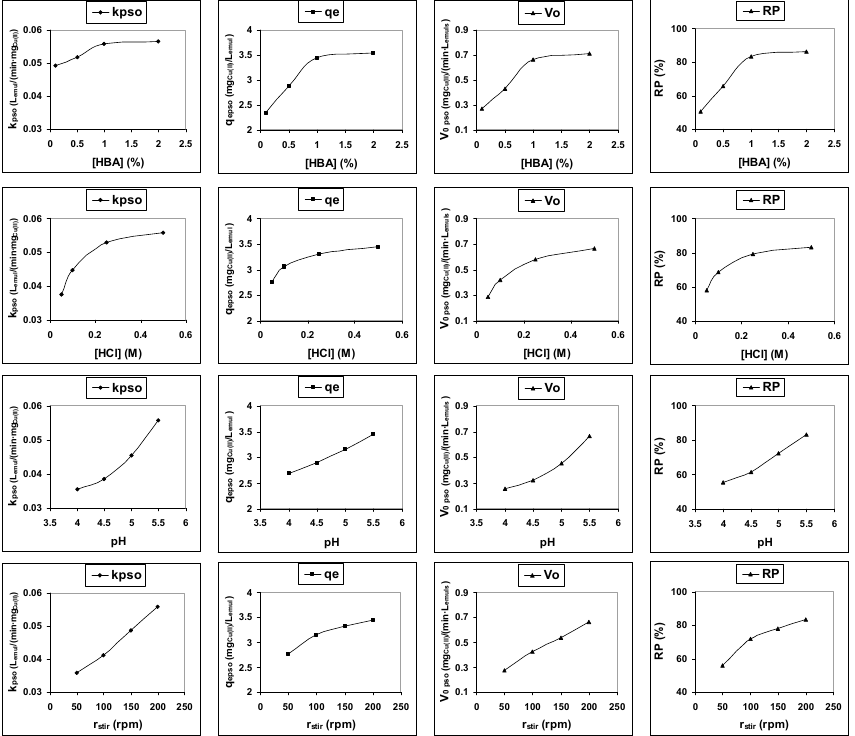
Figure 5. Variation in the values of pseudo-second-order model parameter (k pso , q e,pso , V 0,pso ) and those of the removal percentage (RP) with the different experimental conditions studied.